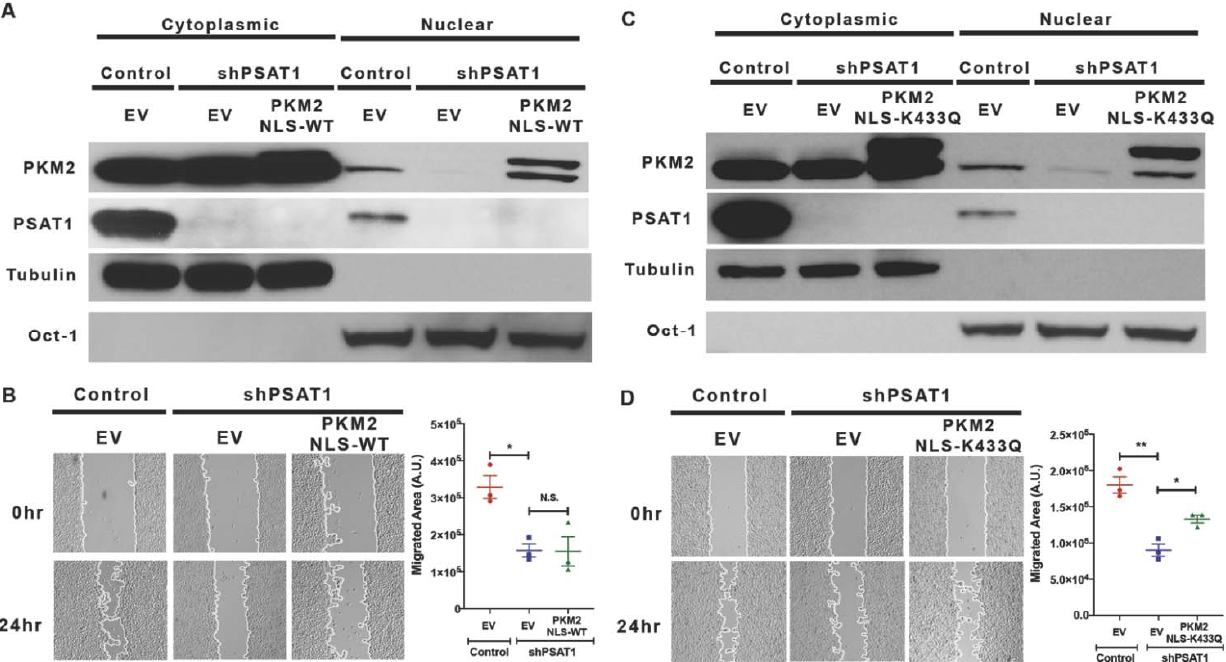
Figure 7. Re ‐ expression of nuclear ‐ localized acetyl ‐ mimetic (K433Q) PKM2, but not wild ‐ type PKM2, partially rescues the migration defect due to the loss of PSAT1. ( A ) Immunoblot analysis for PKM2 localization in PSAT1 ‐ suppressed PC9 cells stably expressing the nuclear ‐ targeted wild ‐ type PKM2 (FLAG ‐ PKM2 NLS ‐ WT ). Cytoplasmic and nuclear fractions from the control ‐ EV, shPSAT1 ‐ EV, and shPSAT1 ‐ FLAG ‐ PKM2 NLS ‐ WT ‐ expressing cells were analyzed using anti ‐ PKM2 and anti ‐ PSAT1 antibodies. Oct ‐ 1 and α‐ tubulin served as loading controls for the nuclear and cytoplasmic compartments, respec ‐ tively. Shown are representative images from three independent experiments. ( B ) Wound healing assay of serum ‐ starved PC9 cells expressing the control ‐ EV, shPSAT1 ‐ EV, or shPSAT1 ‐ FLAG ‐ PKM2 NLS ‐ WT . Shown are representative images at 0 h and 24 h with migrating cells demarcated by continuous white lines. Data are presented as a mean ± SE migrated area after 24 h from three independent experiments. A statistical significance was determined by a one ‐ way ANOVA with Tukey’s multiple comparison test. * p < 0.0001 and N.S.: not significant. ( C ) Immunoblot analysis for PKM2 localization in PSAT1 ‐ suppressed PC9 cells stably expressing nuclear ‐ targeted acetyl ‐ mimetic (K433Q) PKM2. Cytoplasmic and nuclear fractions from the control ‐ EV, shPSAT1 ‐ EV, and shPSAT1 ‐ FLAG ‐ PKM2 NLS ‐ K433Q ‐ expressing cells were analyzed using anti ‐ PKM2 and anti ‐ PSAT1 antibodies. Oct ‐ 1 and α‐ tubulin served as loading controls for the nuclear and cytoplasmic com ‐ partments, respectively. Shown are representative images from three independent experiments. ( D ) Wound healing assay of serum ‐ starved PC9 cells expressing the control ‐ EV or shPSAT1 ‐ EV and shPSAT1 ‐ FLAG ‐ PKM2 NLS ‐ K433Q . Shown are rep ‐ resentative images at 0 h and 24 h with migrating cells demarcated by continuous white lines. Data are presented as a mean ± SE migrated area after 24 h from three independent experiments. A statistical significance was determined by a one ‐ way ANOVA with Tukey’s multiple comparison test. ** p < 0.0001 and * p < 0.05. EV: empty vector; A.U .: arbitrary unit; NLS: nuclear localization signal.